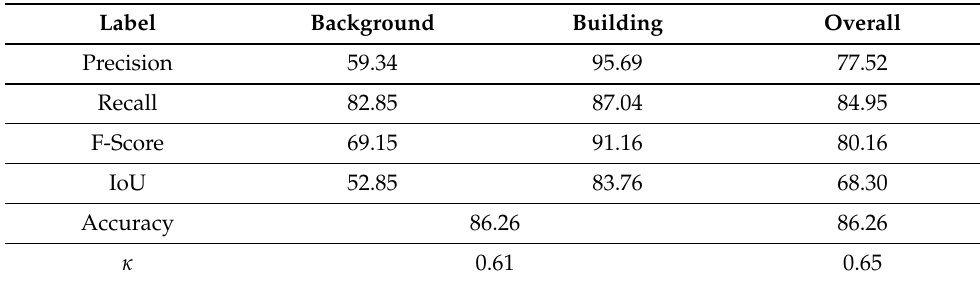
Table 1. Accuracy metrics of our Bayesian U-Net on the Massachussets dataset.